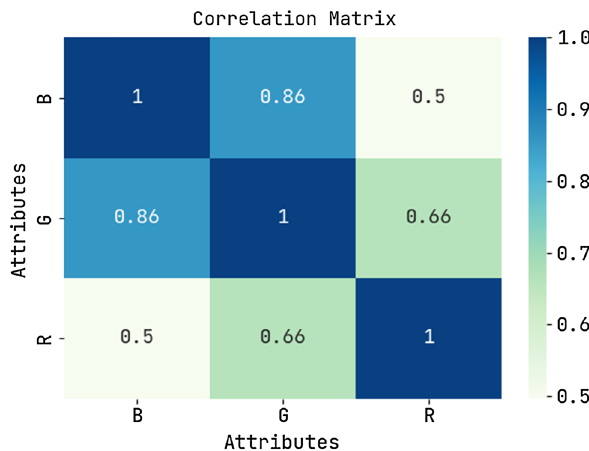
Fig. 5 Confusion matrix of CICC-BDVMR technique on localization